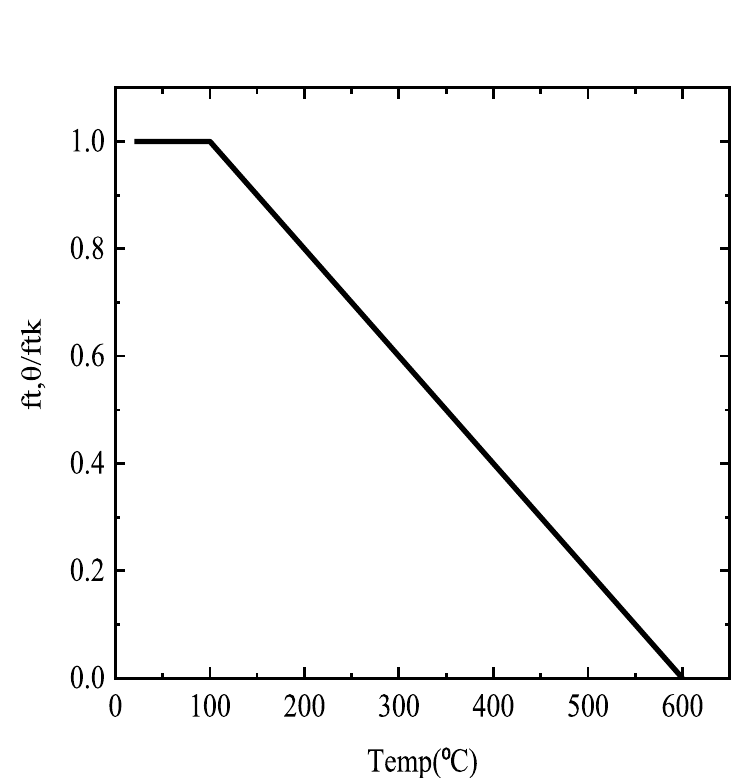
Fig. 18 Tensile strength of concrete at elevated temperatures